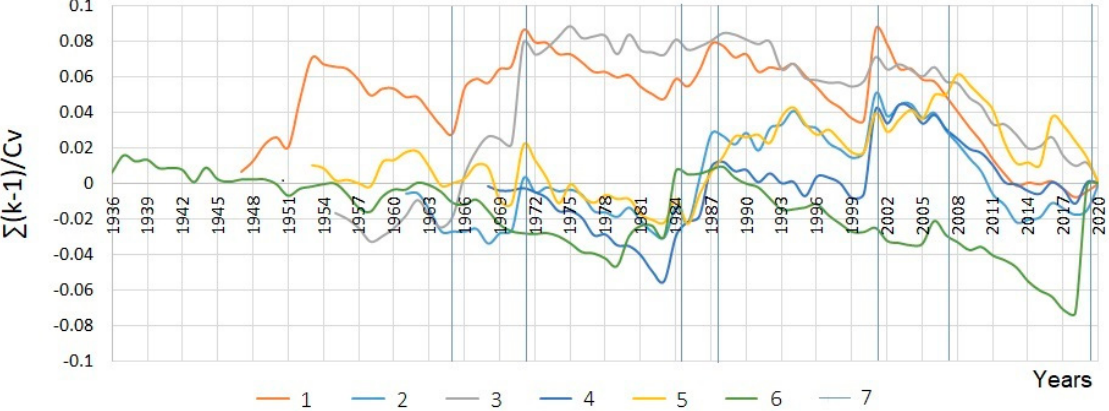
Figure 2. Long-term changes in the maximum annual discharges in the Angara River basin in the form of differential integral curves; k—modulus code, Cv is variation coefficient. 1—Kitoi–Kitoi, 2— Kitoi–Dabady, 3—Irkut–Tibelti, 4—Belaya–Mishelevka, 5—Irkut–Tunka, 6—Iya–Tulun, 7—periods of water content.